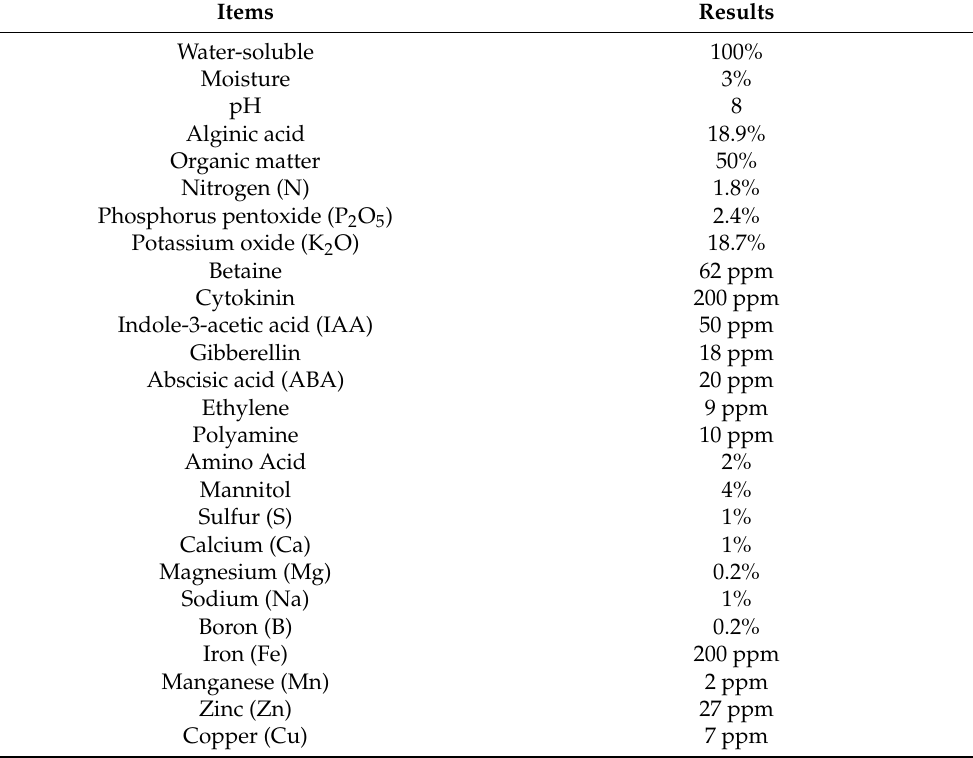
Table 1. Product analysis of Ascophyllum nodosum Seaweed Extract. Items Results Water-soluble 100% Moisture 3% pH 8 Alginic acid 18.9% Organic matter